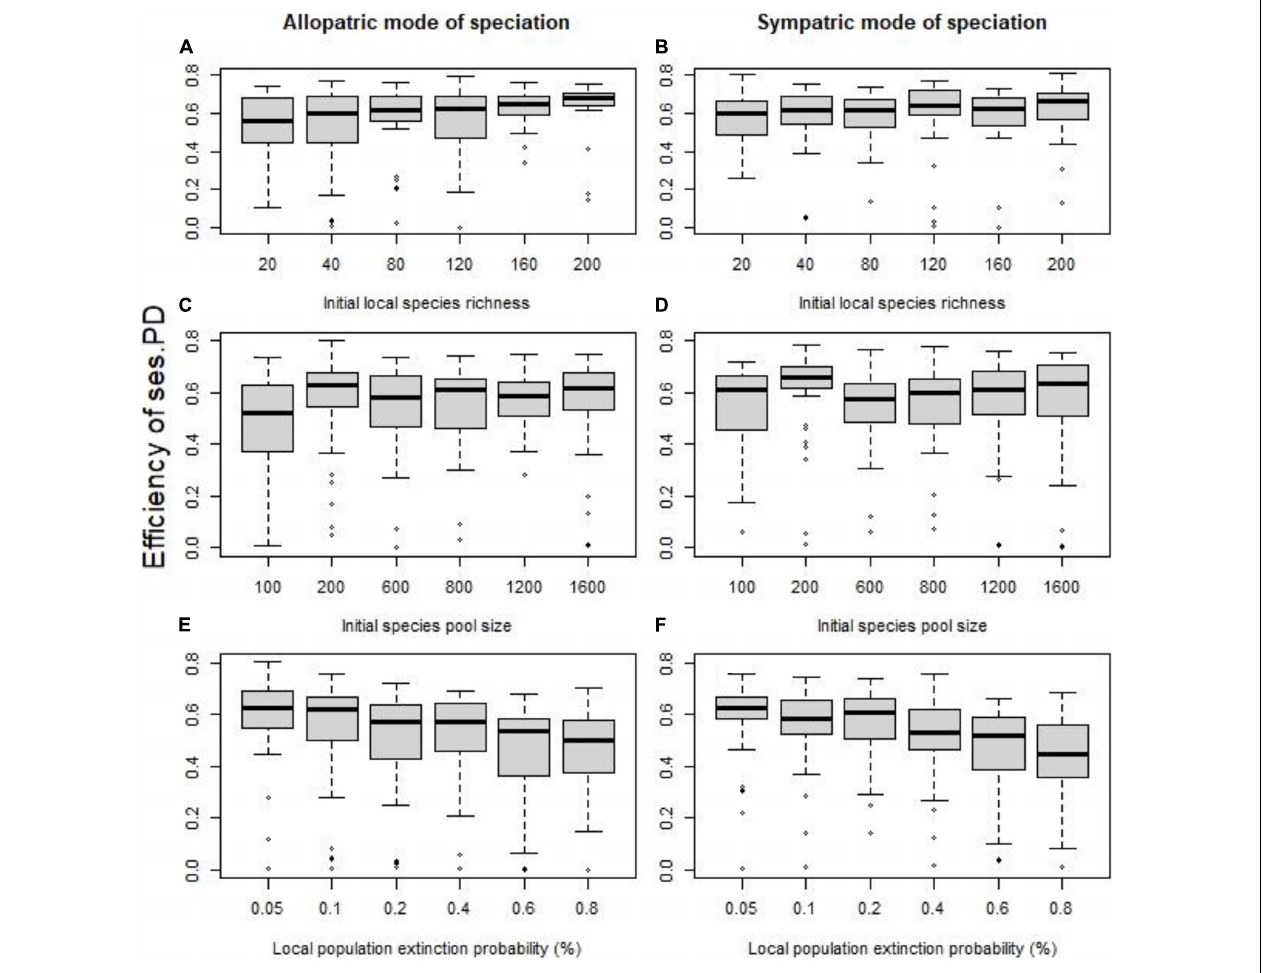
FIGURE 3 | With a 5% probability of dispersal for each local population to its nearest neighbor cell, the effect of the initial local species richness for fixed species pool (A,B) , the size of the initial species pool for fixed species richness per cell (C,D) , and the probability of local extinctions (E,F) on the efficiency of the standardized effect size of PD as indicator of speciation history (quantified using the coefficient of determination R 2 ). The allopatric speciation mode results are in the left column, while the sympatric speciation mode results in the right column. To assess the role of each factor independently we kept all the other values fixed at their default values (initial local richness = 40 species, species pool size = 400 species, probability of local extinction =